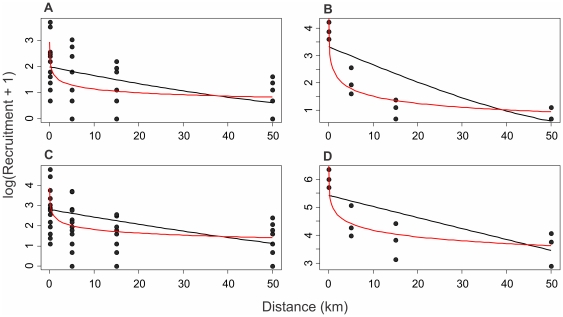
Recruitment (Log) plotted as a function of distance for A. cincta recruits (a), planktonic A. cincta collected in plankton samples (b), all gastropod recruits (c) and all planktonic gastropods collected in plankton samples (d). Lines illustrate fitted models for exponential models (black lines) and power law models (red lines).